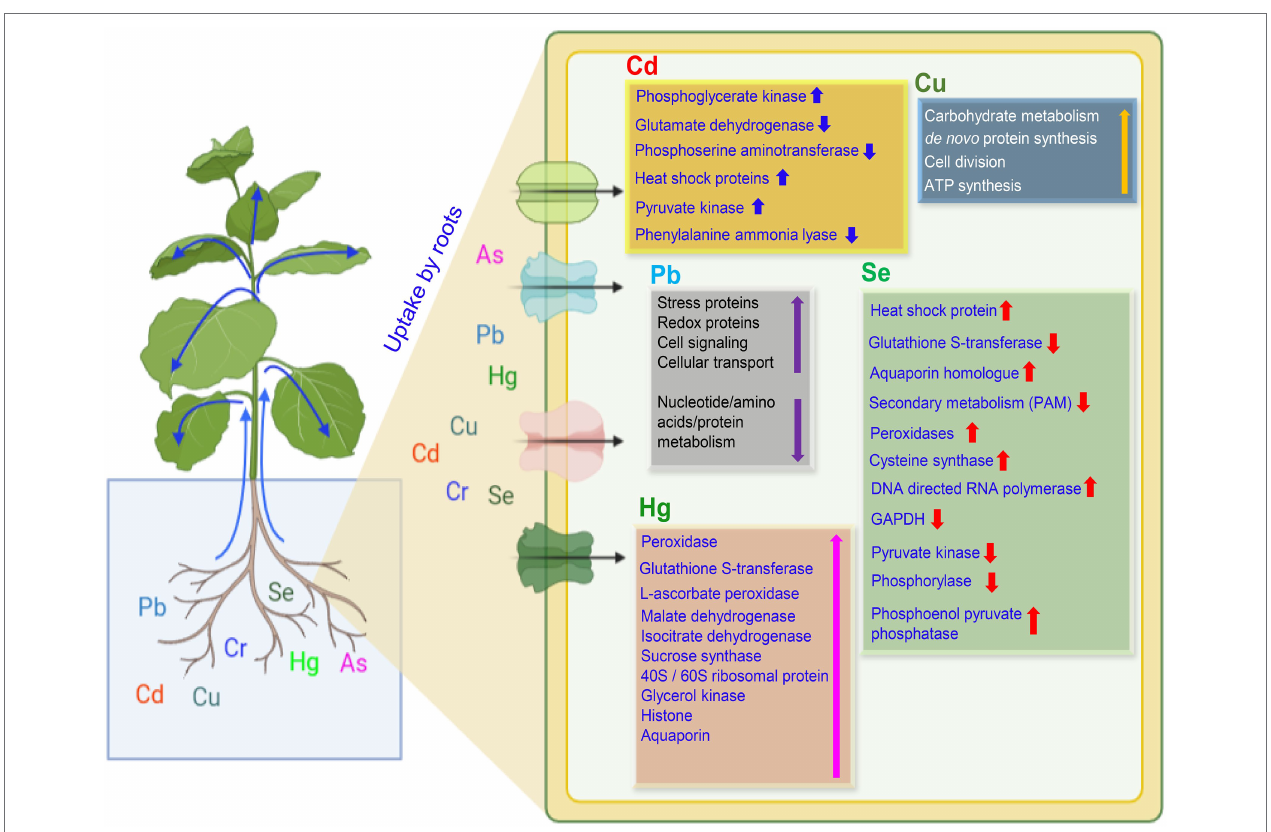
FIGURE 5 | A proposed model on the uptake of potentially toxic elements and plant response in the roots. Uptake of PTEs by plant roots causing significant up- or down-regulation of essential proteins or enzymes as represented by up and down arrows, respectively. Up and down blue arrows are for Cd, yellow for Cu, violet for Pb, red for Se, and pink for Hg. Abbreviations: GAPDH, Glyceraldehyde 3-phosphate dehydrogenase, and ATP, Adenosine